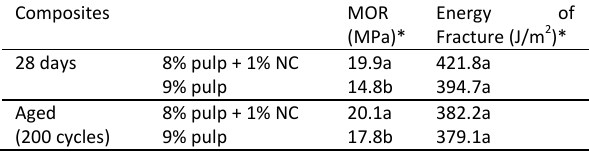
Table 1. Mechanical performance of hybrid composites and composites reinforced with pulp at 28 days and after 200 cycles of immersion and drying